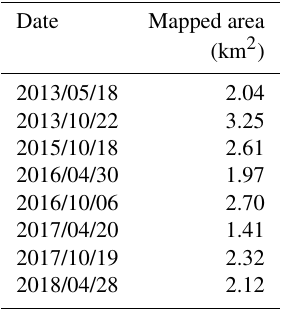
Table 1. Date of acquisition (in yyyy/mm/dd format) and area of the different